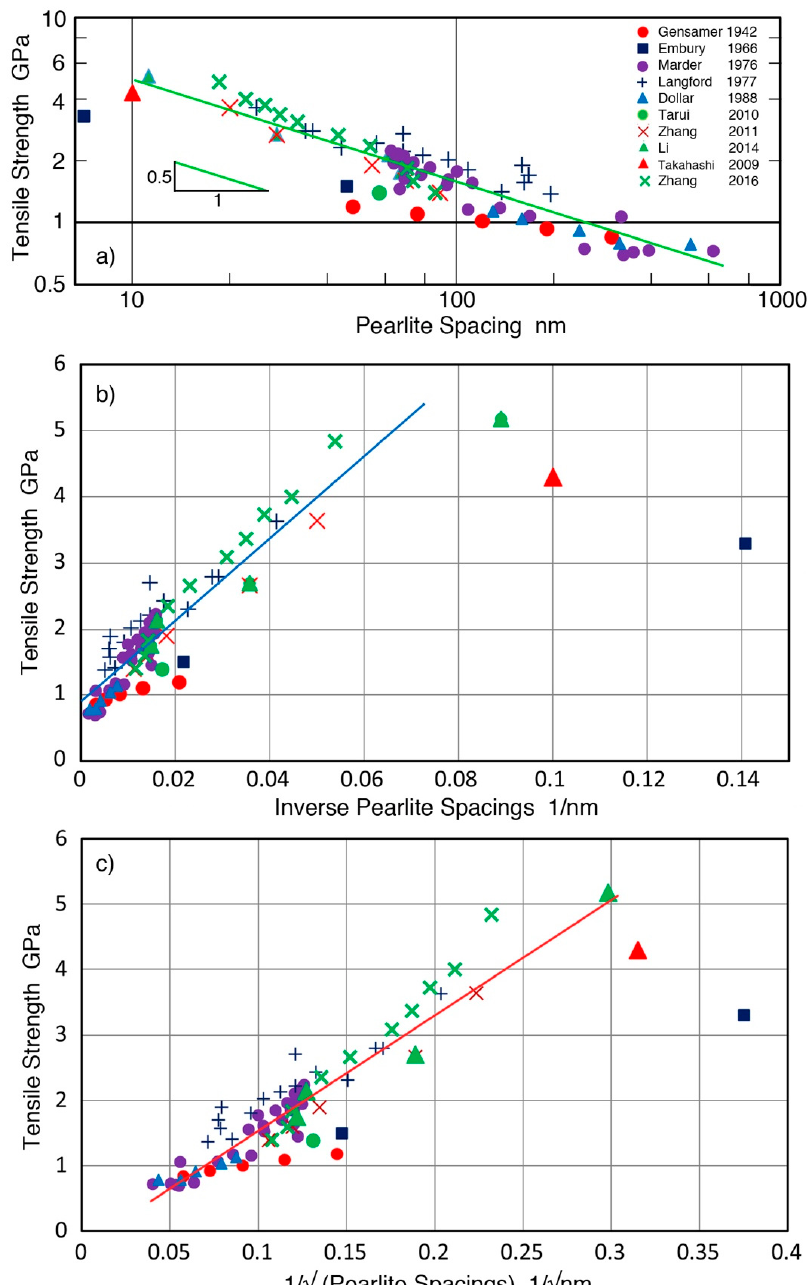
Figure 7. Tensile strength versus length parameters using data from [3,29,30,32,34,40,49,50,73,75]. ( a ) Pearlite spacings, in log-log scales. Data symbols are shown as insert. Green line is for a power-law fit with the slope of –0.5 giving R 2 = 0.833. ( b ) Inverse pearlite spacings. Same data symbols as in ( a ). Blue line is the regression line with R 2 = 0.853. ( c ) Inverse square-root of pearlite spacings. Same data symbols as in ( a ). Green line is the regression line with R 2 = 0.868.